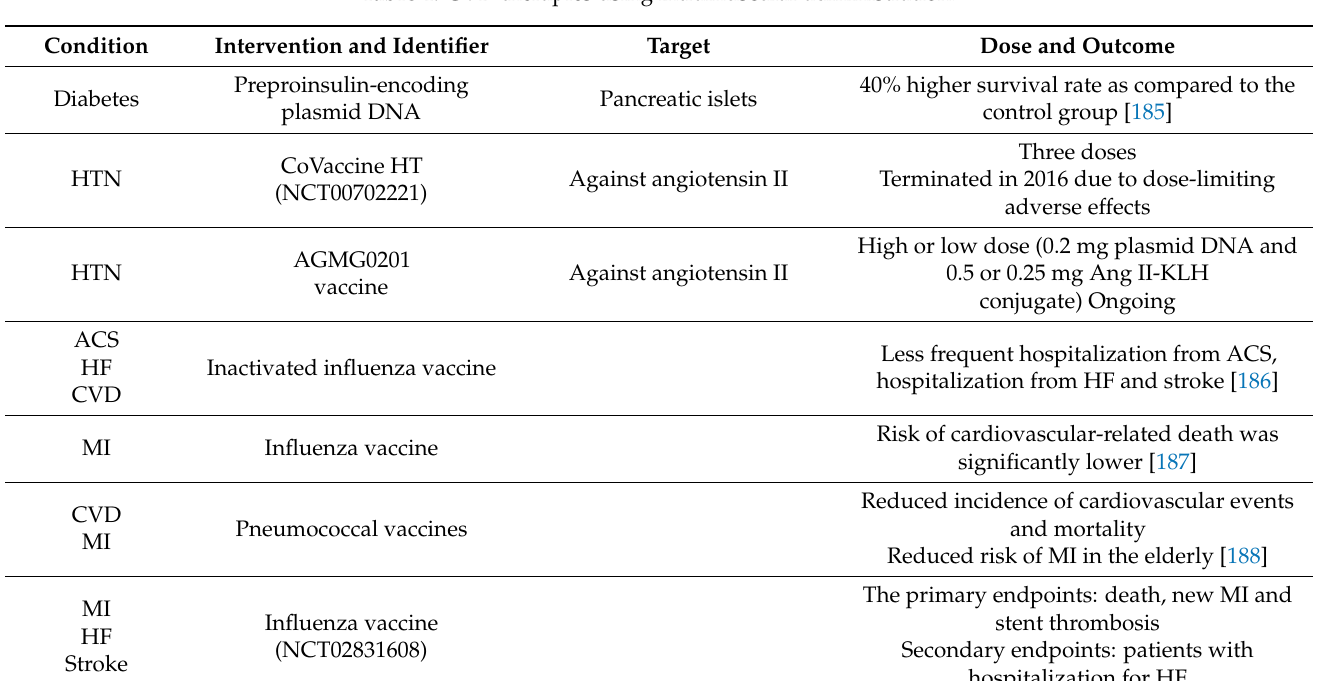
Table 4. CVD therapies using intramuscular